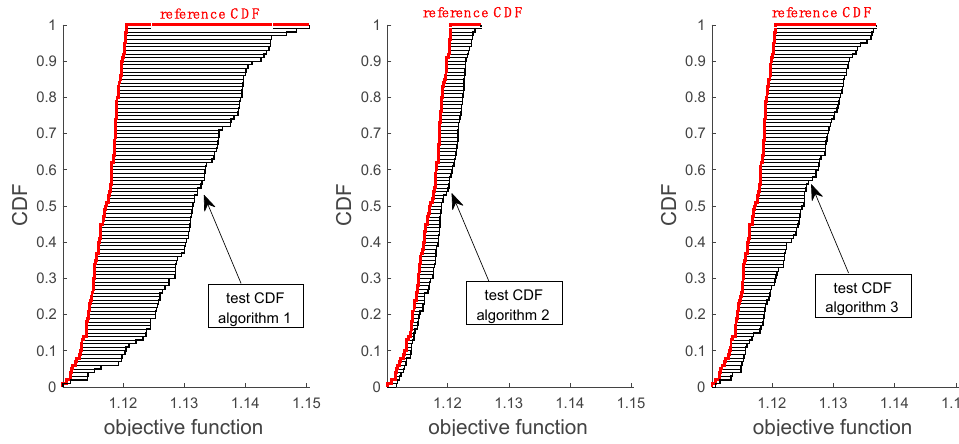
Figure 5. Determination of the areas A for the calculation of the OPISD indicator.